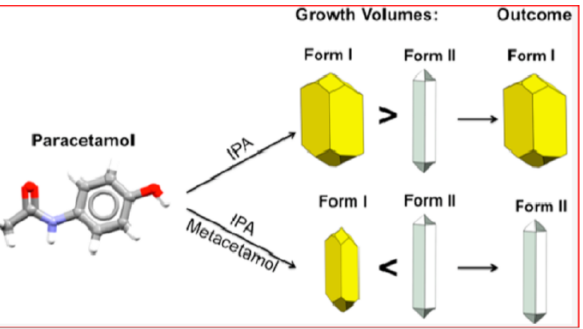
Figure 4. Crystal habits and shapes of the two polymorphs of paracetamol. The outcome of the crystallization can be changed by doping the crystallization with metacetamol. Reprinted with permission from Ref. [28]. 2020, American Chemical